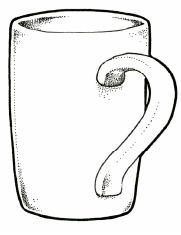
Figure 2. Example of an object with grasping affordance.